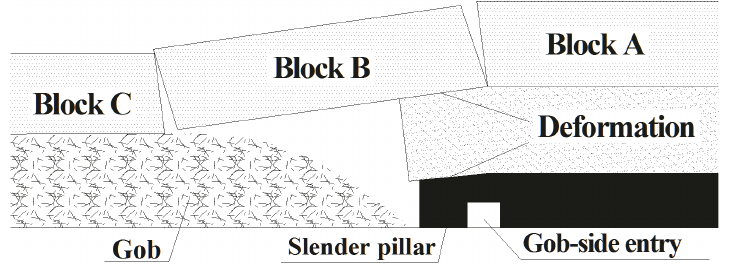
Figure 2: Profile of surrounding rock mass of gob-side entry.